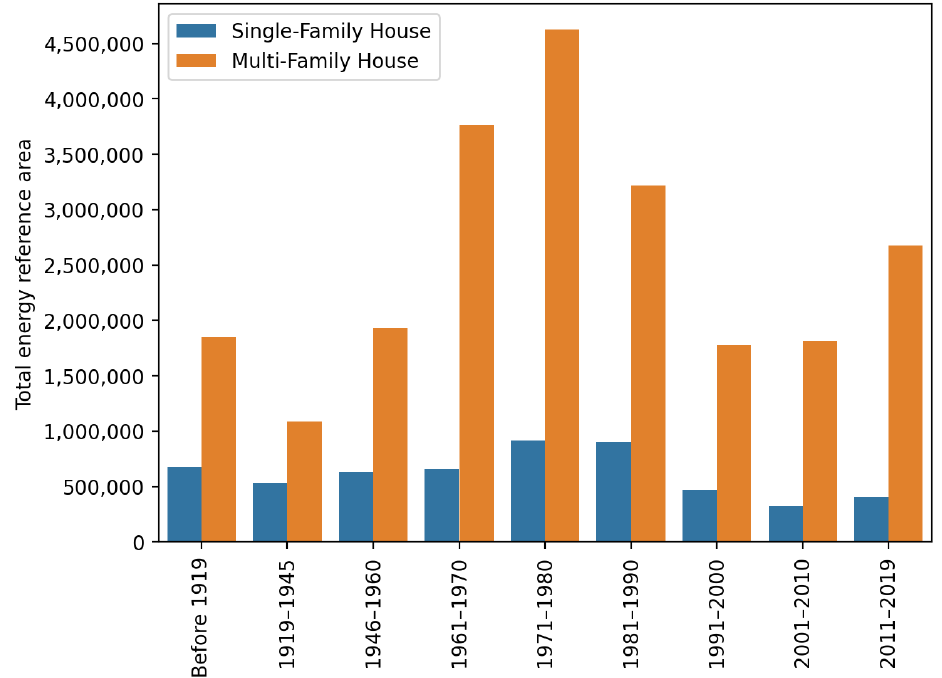
Figure 4. Total energy reference area of single and multi-family houses per year cluster found in the dataset.